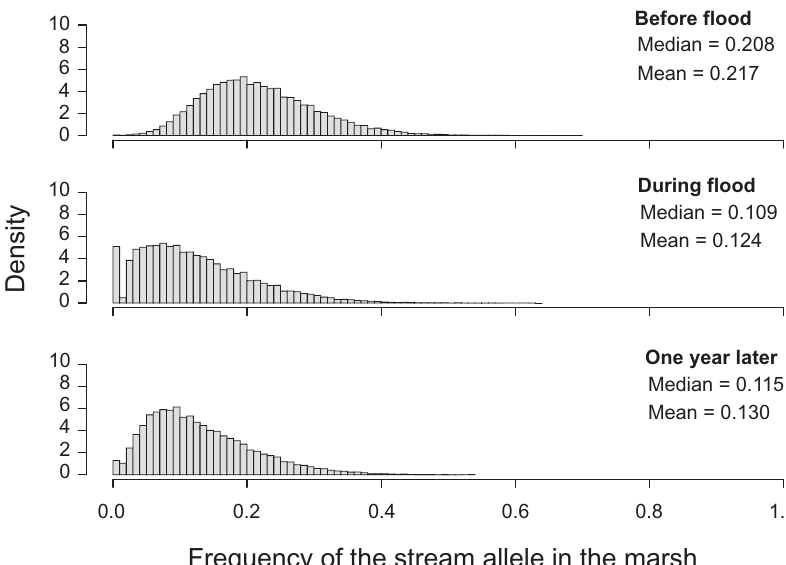
Fig. 7 Impact of a fl ood on the genetic composition of stickleback in the marsh. Shown is the distribution of the frequency of the stream allele across 49,677 SNPs exhibiting strong lake-stream differentiation (AFD ≥ 0.75 in the comparison between the lake pool [sites L1 and L2 combined] and the stream pool [sites S6 and S7 combined]) in stickleback sampled at the marsh site M1 at three different time points. The median and mean of the distributions are also given. Source data are provided as a Source Data fi